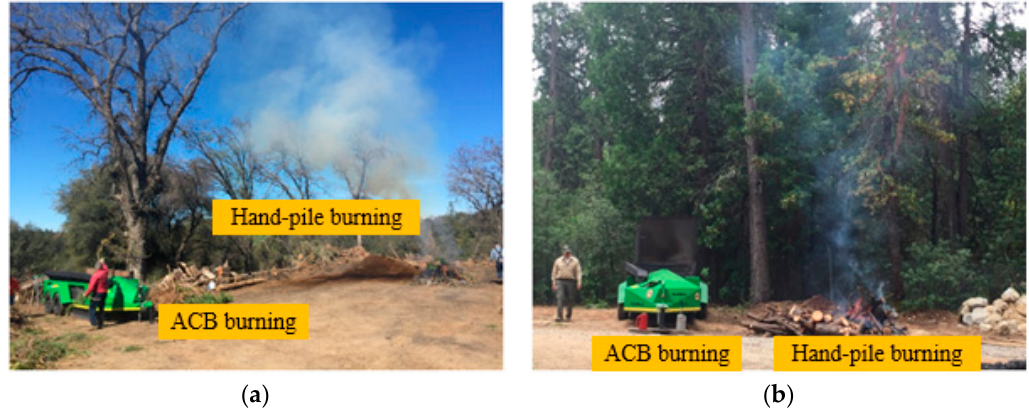
Figure 4. Comparison of the smoke occur from BurnBoss and hand-pile burning for the same types of forest residues; ( a ) Groveland and ( b ) Volcano, California. BurnBoss burnings shows little smoke and air pollutants, compared to hand-pile burnings.